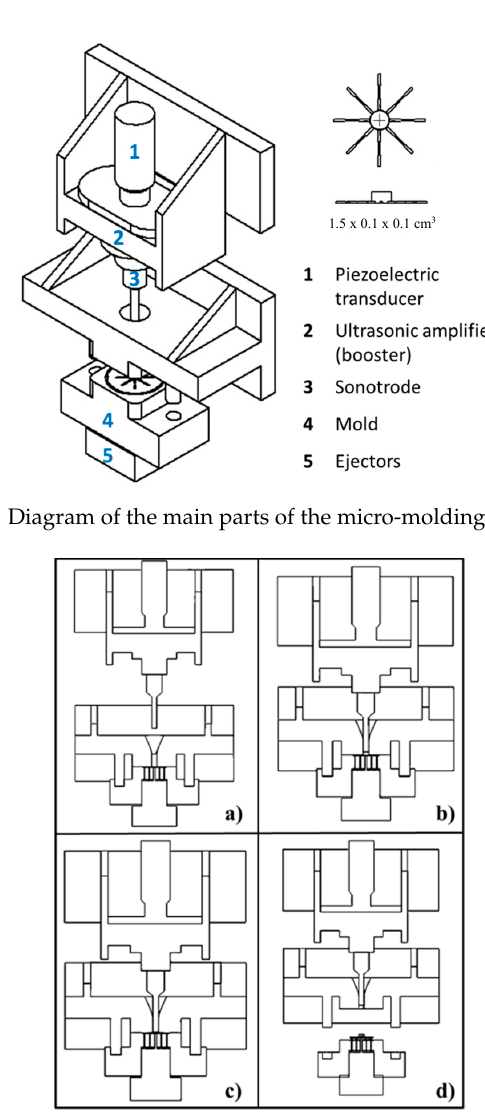
Figure 2. Schematic representation of the molding process: ( a ) feed position; ( b ) compression of sample; ( c ) ultrasound turn on and molding; and ( d ) ejection.